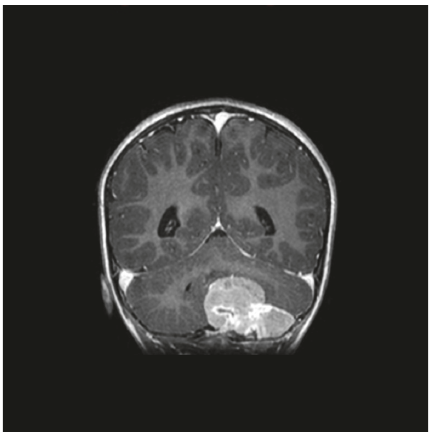
Figure 4: Coronal enhanced T1 weighted image showing intensely enhancing mass invading the skull table.